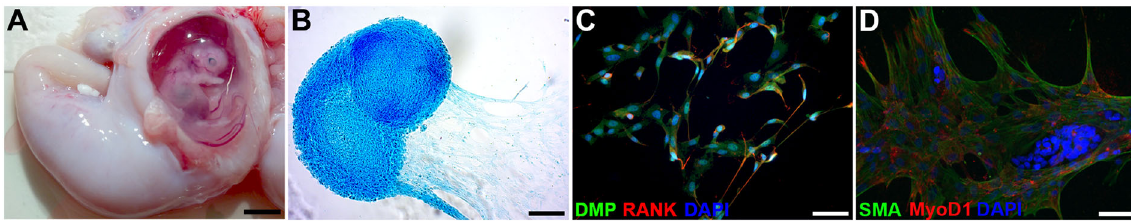
Fig. 5 Pluripotent cells used for the recellularization. Heterogeneous sheep fetal stem cells (SF-SCs) were isolated from a 6 – 8-week-old sheep fetus ( A ). These cells were expanded in vitro and their pluripotency was demonstrated after their differentiation into a chondrogenic lineage (alcian blue positive clusters; B ), an osteogenic lineage positive for dentin matrix acidic phosphoprotein 1 (DMP1) and receptor activator of nuclear factor κ B (RANK; C ), and a myogenic lineage positive for smooth muscle cell actin (SMA) and myoblast determination protein 1 (MyoD1; D ). Scale bars; 5 cm ( A ), and 100 μ m ( B – D ).